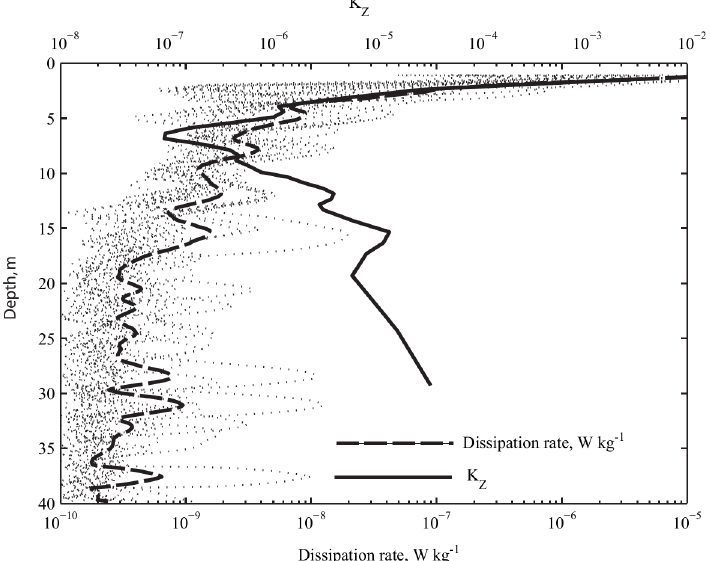
Fig 3. Turbulent mixing within the water column during the field experiment. Turbulent diffusion coefficient K Z averaged for the study period (thick solid line) and the dissipation rate of the turbulent kinetic energy (thin dash lines are individual profiles; thick dash line is the average for the whole study). doi:10.1371/journal.pone.0131431.g003 ~15 m and 65 m. Therefore, the bulk of the water column was a nearly homogeneous non-tur- bulent environment, close to the classical Stokes ’ condition.